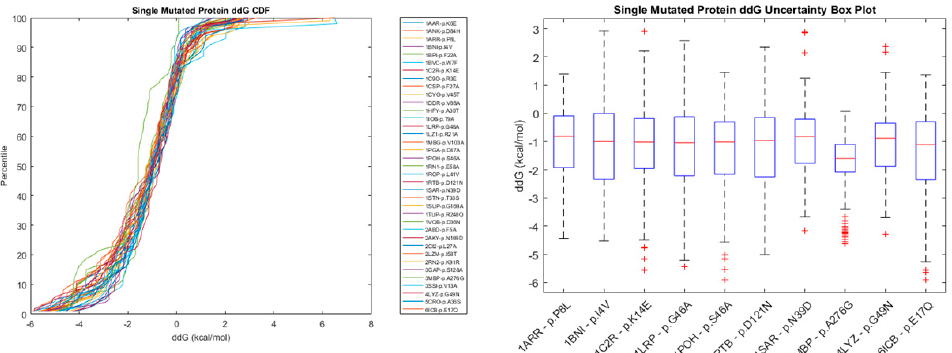
Figure 5. Cumulative distribution function of energy changes and the uncertainty plot for selected proteins with a single point